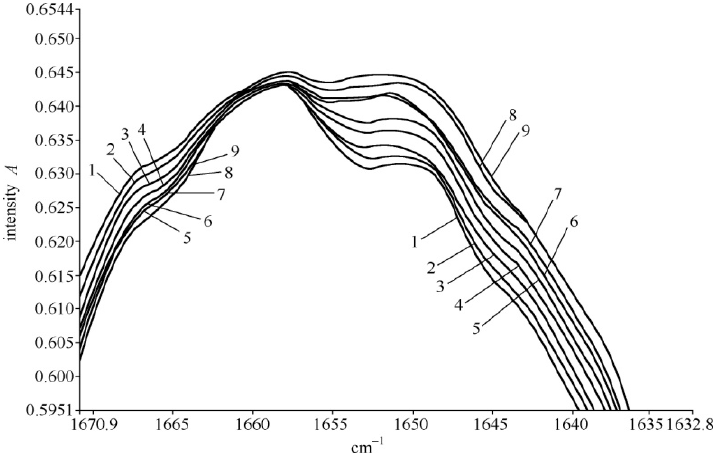
Figure 9. Changes of intensity for infrared absorption of collagen in the region at (1) 95 °C; (2) 85 °C; (3) 75; (4) 65 °C; (5) 55 °C; (6) 45 °C; (7) 35 °C; (8) 25 °C; and (9) 15 °C.